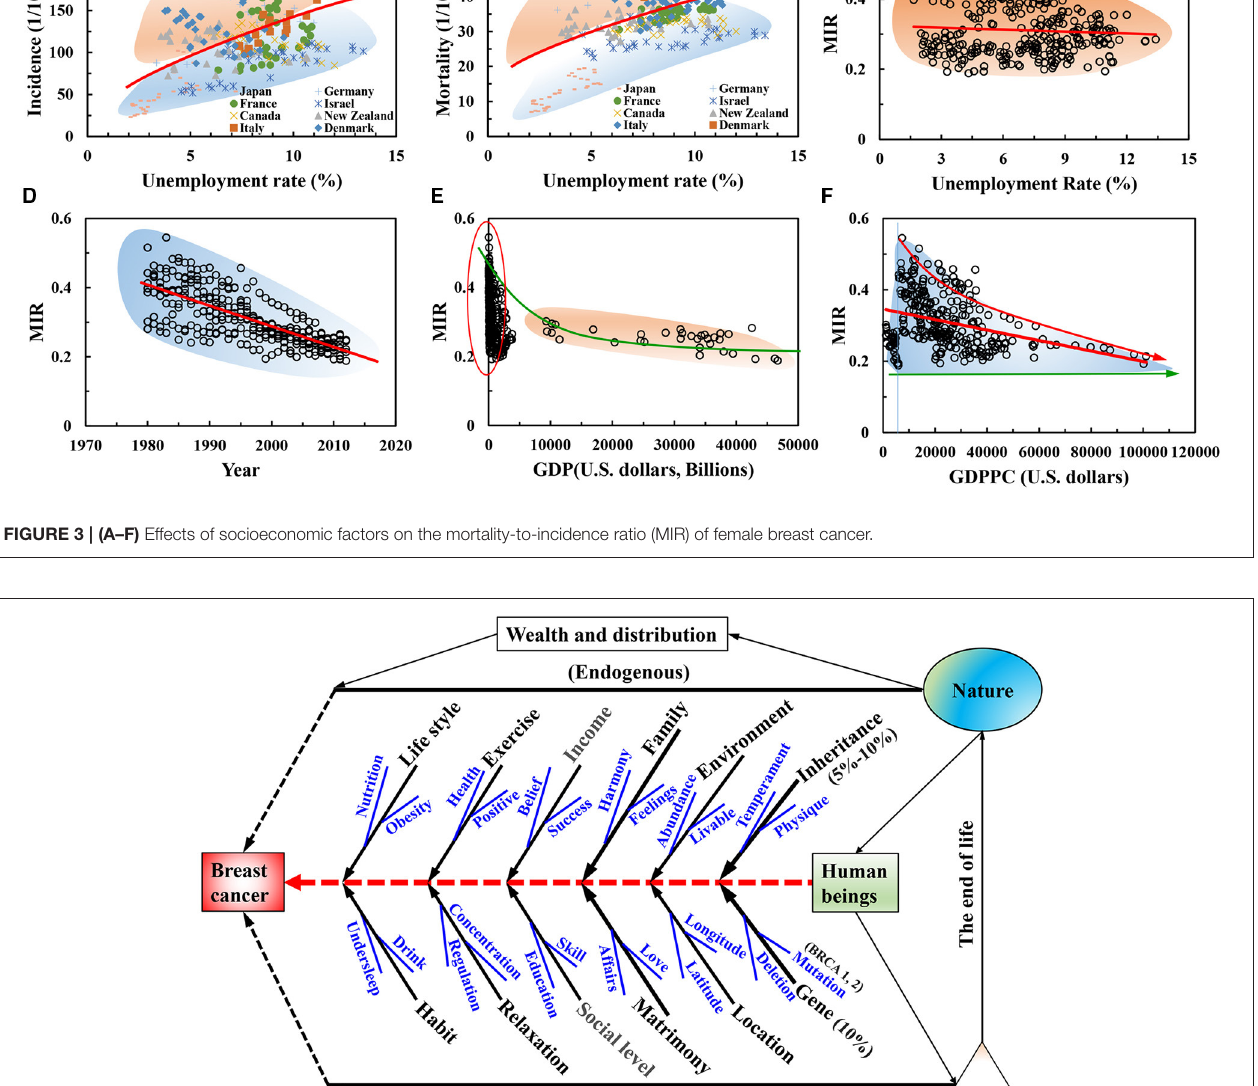
On MIR The 5-year survival rate of breast cancer usually is proxied by MIR of breast cancer for women health (42), Adams et al. investigated the accessibility and importance of mammography services (56). We further investigated the influences of four socioeconomic factors (such as, years, GDP, GDPPC, and UR) on MIR of female breast cancer, as shown in Figures 3C–F